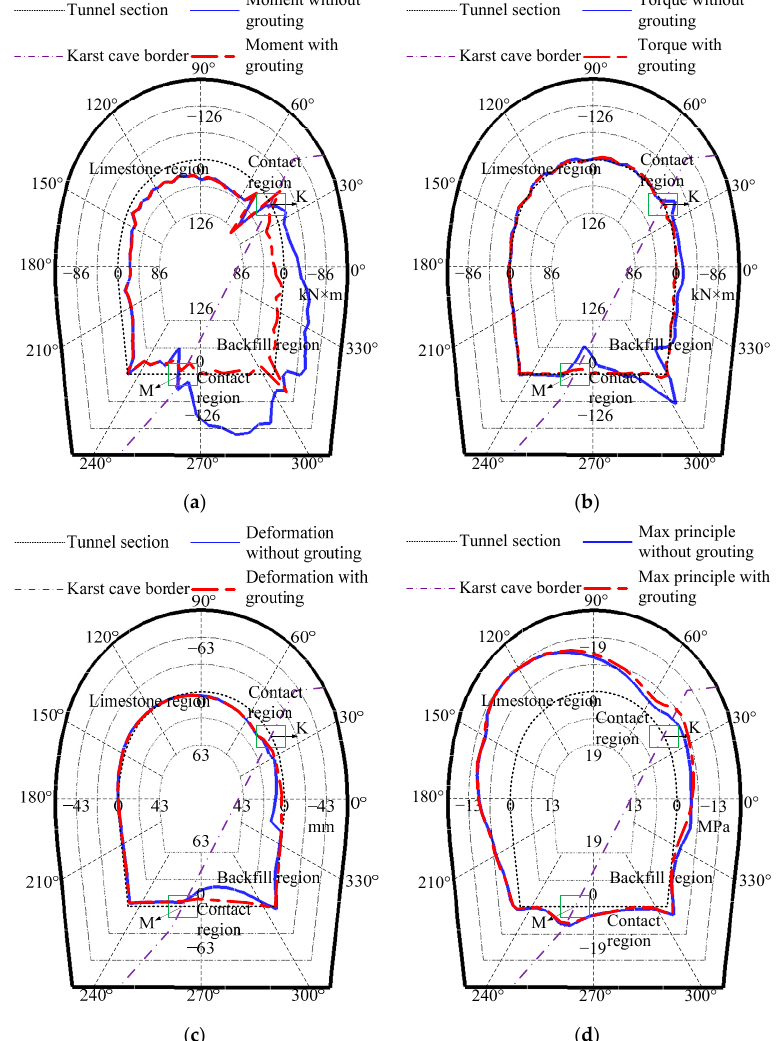
Figure 8. Mechanical response of I-type tunnel on Y = 10 m section ( a ) bending moment ( b ) torque ( c ) deformation and ( d ) max principle of support.